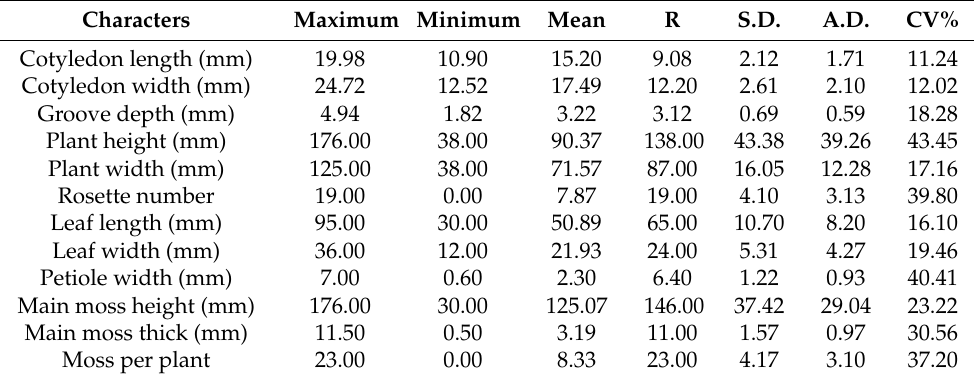
Table 4. Analysis on quantitative characters of 60 mustard